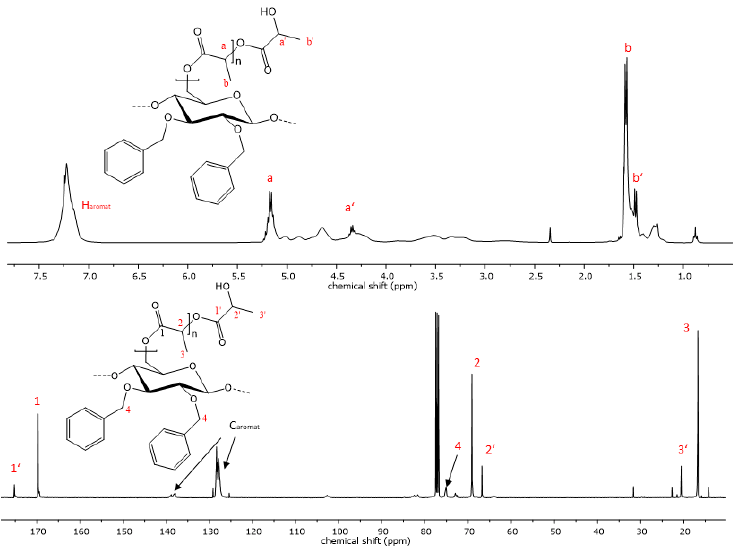
Figure 5. Representative 1 H- and 13 C-NMR spectrum of copolymer 12 with PLA